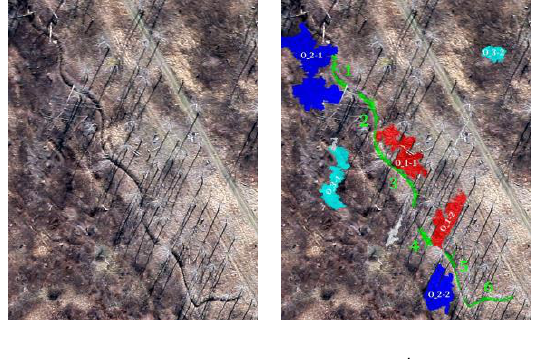
Figure 2. a) The cut part of the colour (RGB) image (Canon EOS 5D) of the trench 1 in the lowland type of the terrain, and b) the presentation of the trench (light green) sections, and of the surrounding patterns (red, dark blue, light blue) on the same image (ITF, 2008).